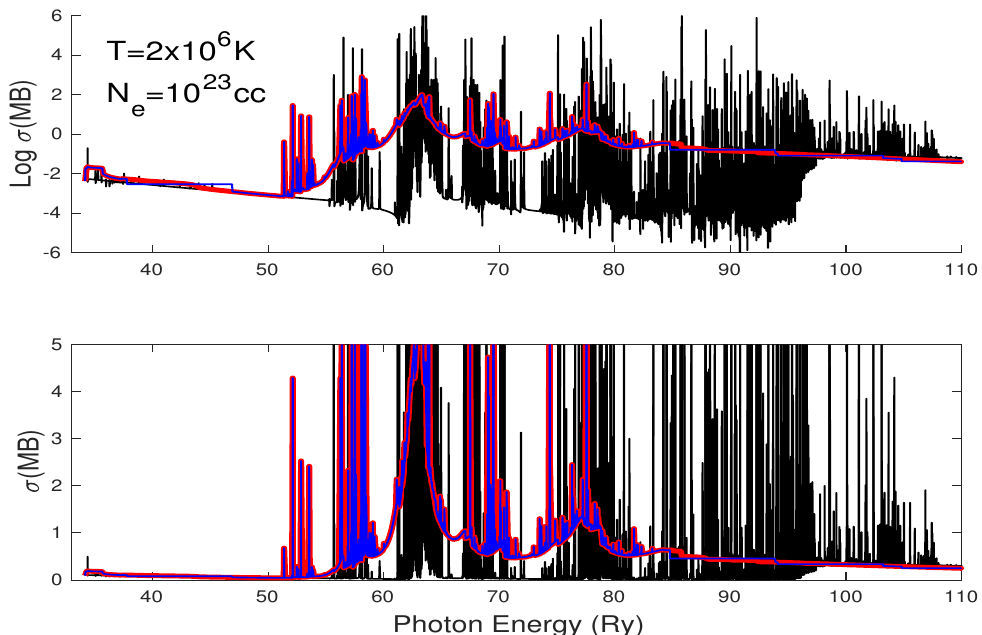
Figure 2. Energy–temperature–density-dependent photoionization cross section of highly excited bound level 2 s 2 2 p 5 3 p 2 D 2 of Fe XVII −→ e + Fe XVIII , due to plasma broadening of autoionizing resonances: unbroadened—black curve, broadened—red and blue (see text). Top panel: Log σ (MB) in the full energy range up to the highest ionization threshold of core ion Fe XVIII , bottom panel: Linear-scale σ PI in the energy range of the largest AI